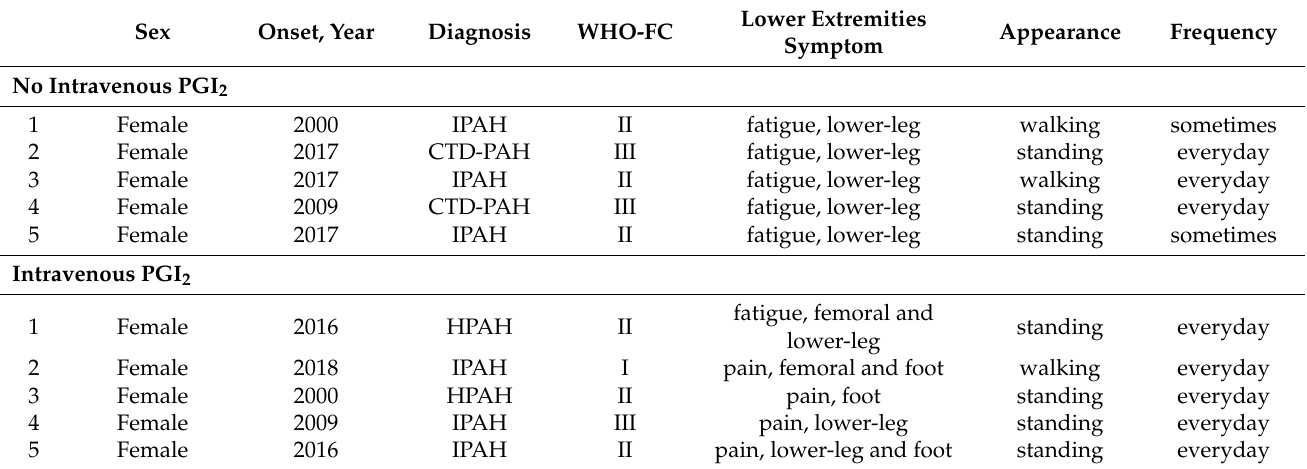
Table 3. Patients’ clinical characteristics and symptoms.